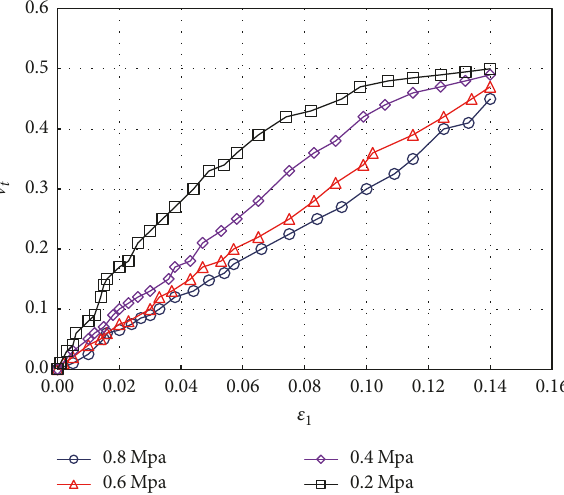
Figure 13: Chart comparing the measured and predicted V 𝑡 values.